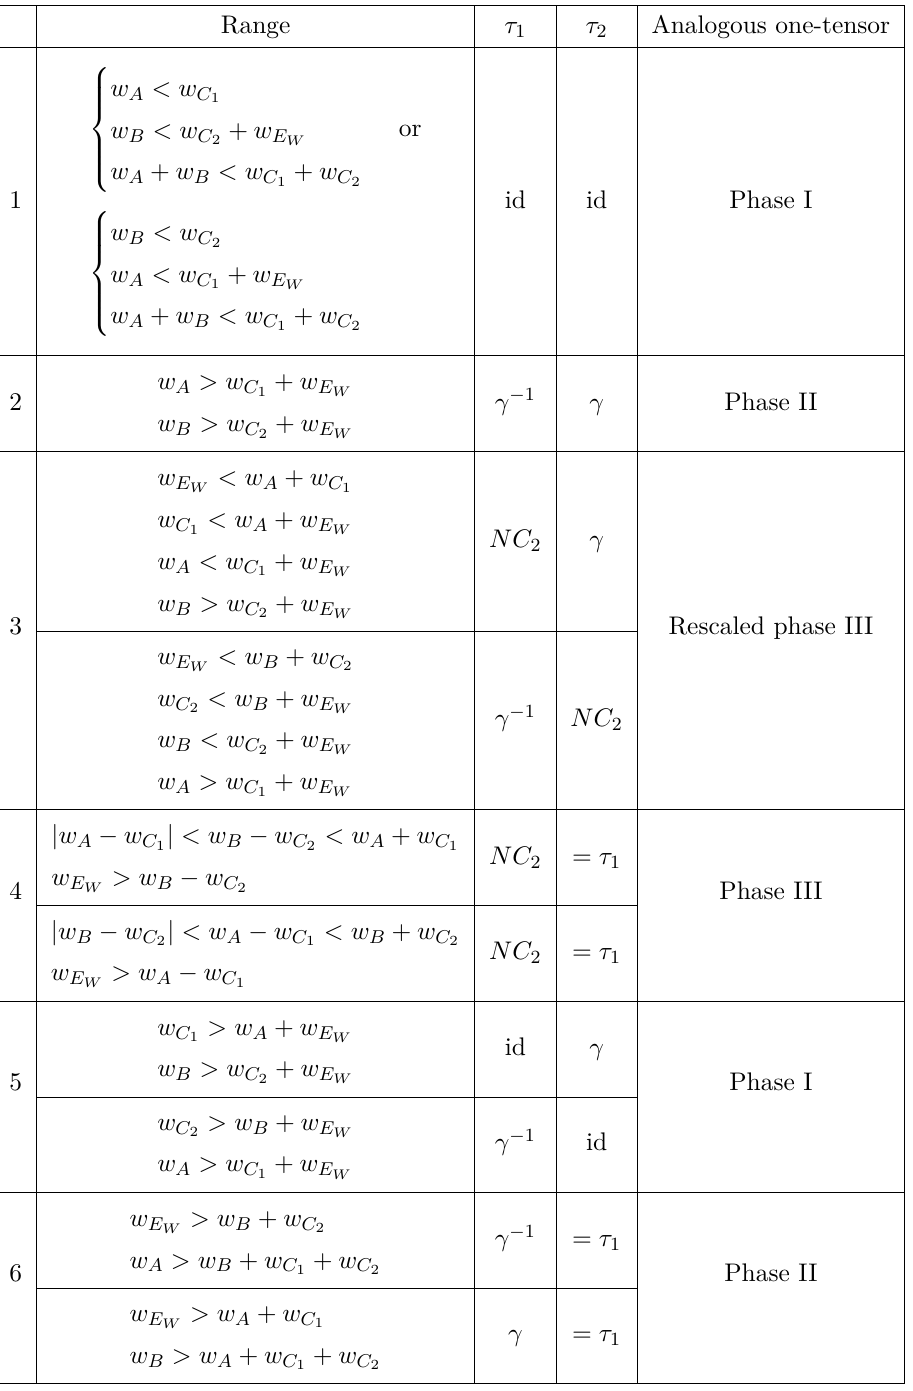
Table 1 . Phases of a two-tensor network. We show the range of each phase corresponding to the intersection of the inequalities and the values of the permutations that give the dominant contribution. In these cases, the behavior in each phase can be mapped to a possibly rescaled phase of the one-tensor network, and this is shown in the table. A permutation is in NC non-crossing and consists of only 2-cycles, unless it is of odd size and in such a case it also has a single